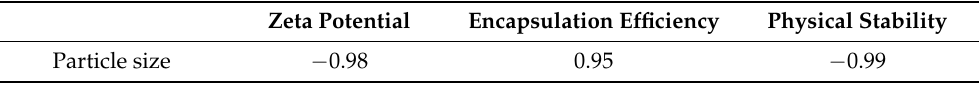
Table 2. Correlation matrix between particle size and zeta potential, encapsulation efficiency, and physical stability of liposomes containing the saffron